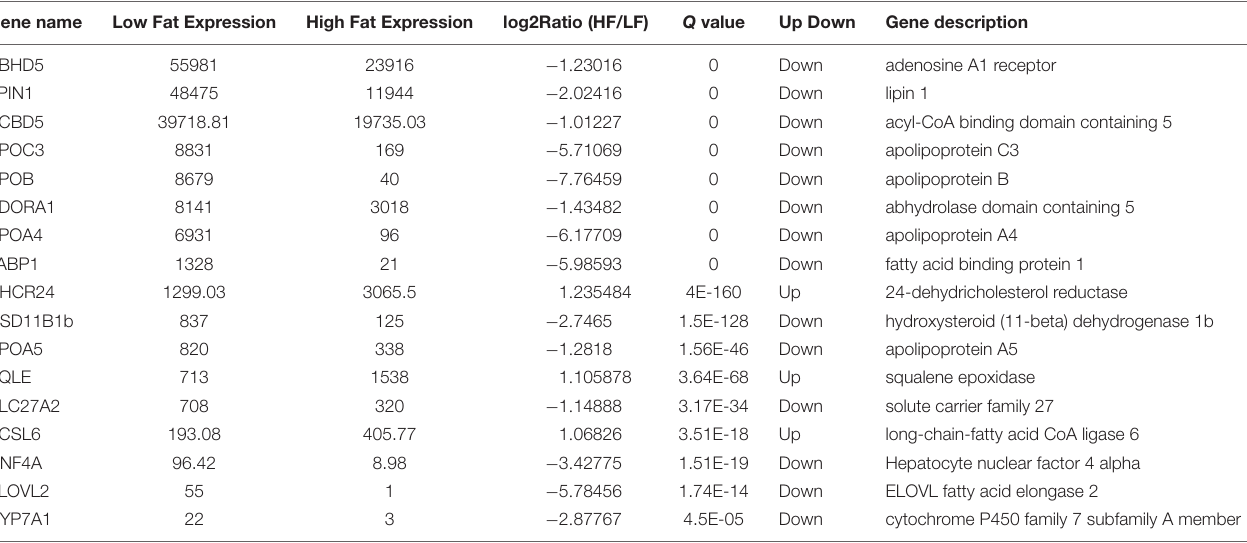
TABLE 3 | The potential candidates for abdominal fat